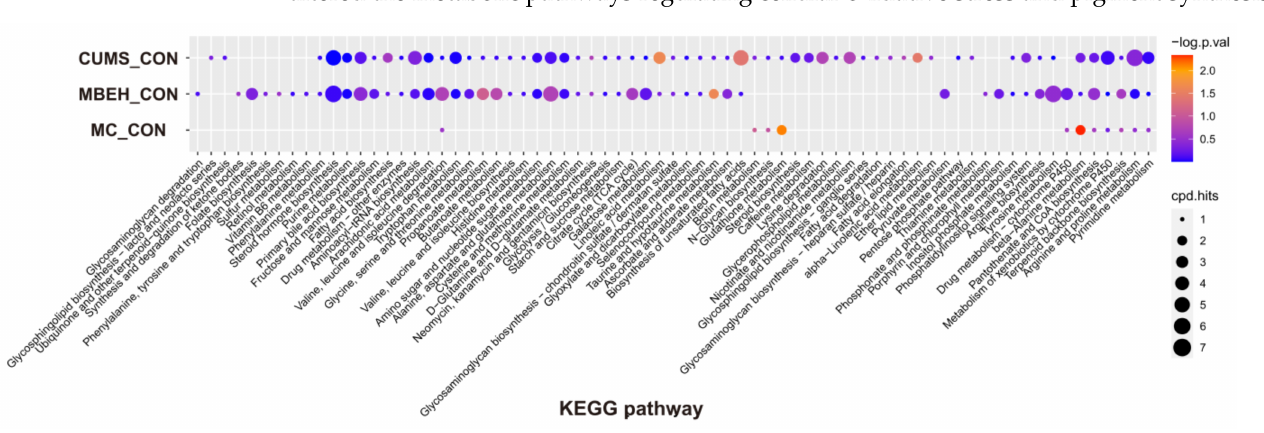
Figure 6. Analysis of KEGG enrichment of differential metabolites in the skin of CUMS, MBEH and MC